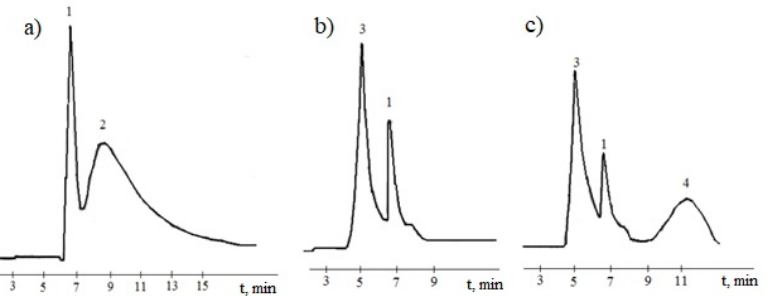
Figure 9. Liquid chromatogram of a mixture of 1,3,5-trioxybenzene and 2-furaldehyde in water ( a ) and the reaction mixture after 20 min ( b ) and 40 min ( c ): 1-peak of 1,3,5-trioxybenzene; 2-peak of 2-furaldehyde; 3-mono derivatives of phloroglucinol and furfural; 4-oligomers.